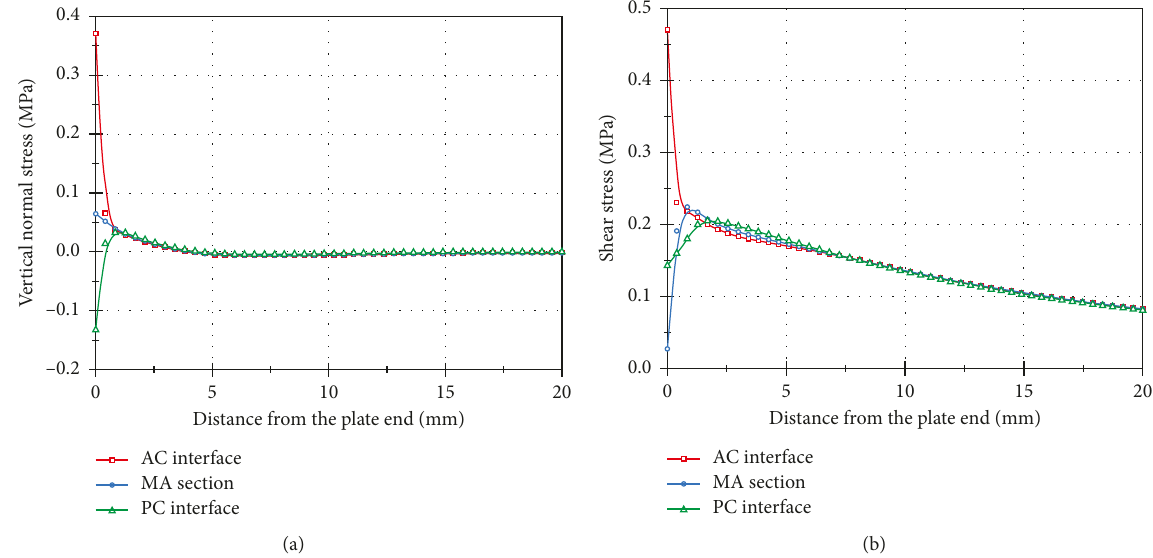
Figure 11: Interfacial Stress distributions under instantaneous loading. (a) Vertical normal stress. (b) Shear